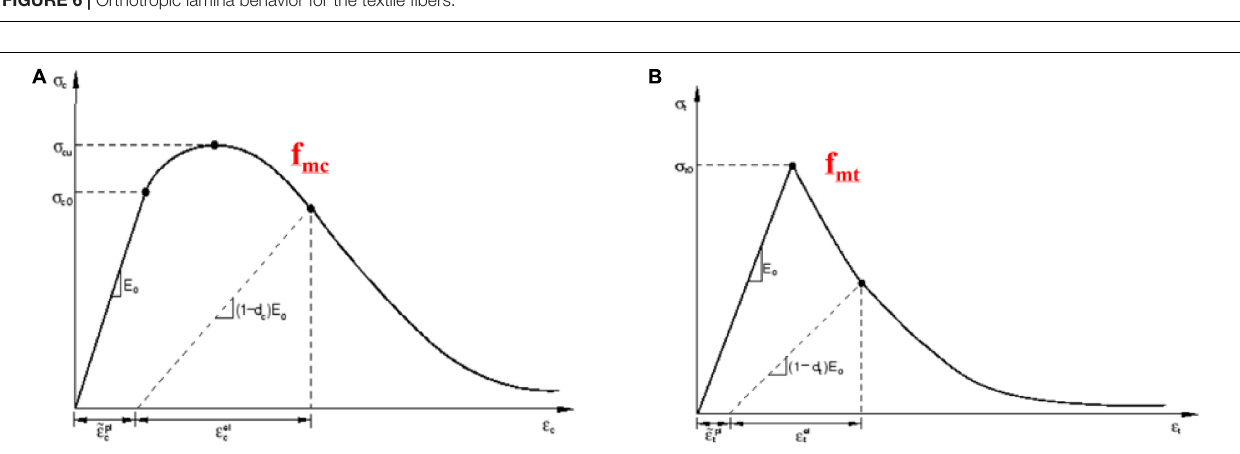
are tie nodes with both translational and rotational degrees of freedom associated to the motion of the reference point. The specimens presents restrained nodes on the top while an imposed displacement is applied on the bottom to the reference point.